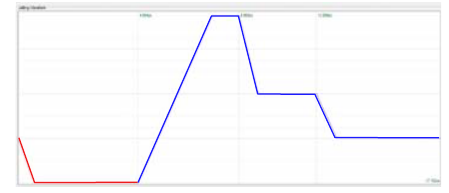
Figure 1: The used jetting pulse